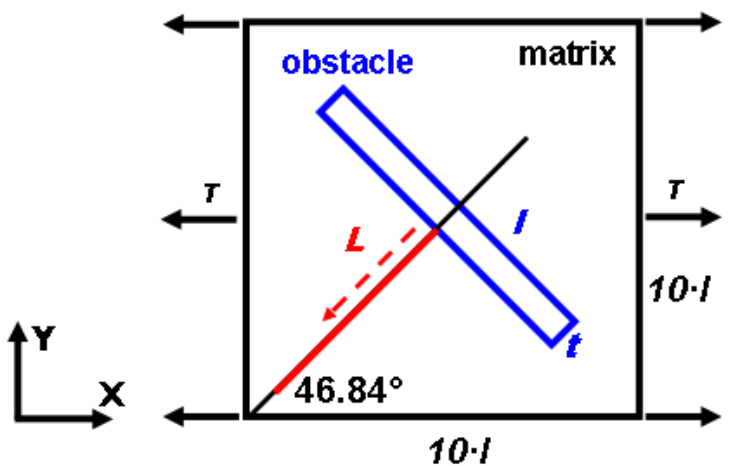
Figure 2. The FE model geometry, with loading conditions and location for stress analysis (red line). The size of the obstacle is not to scale.